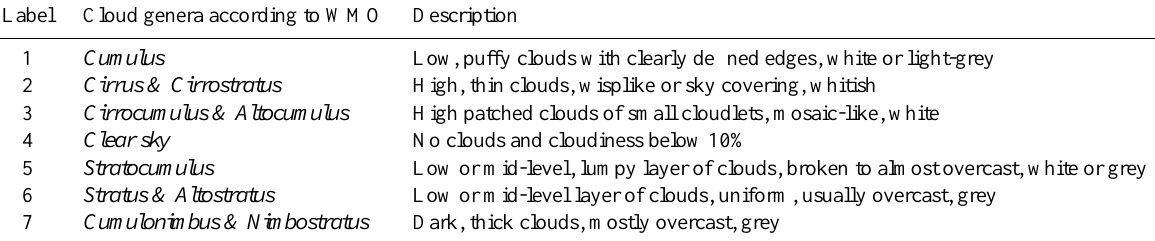
Table 1. Classes to be